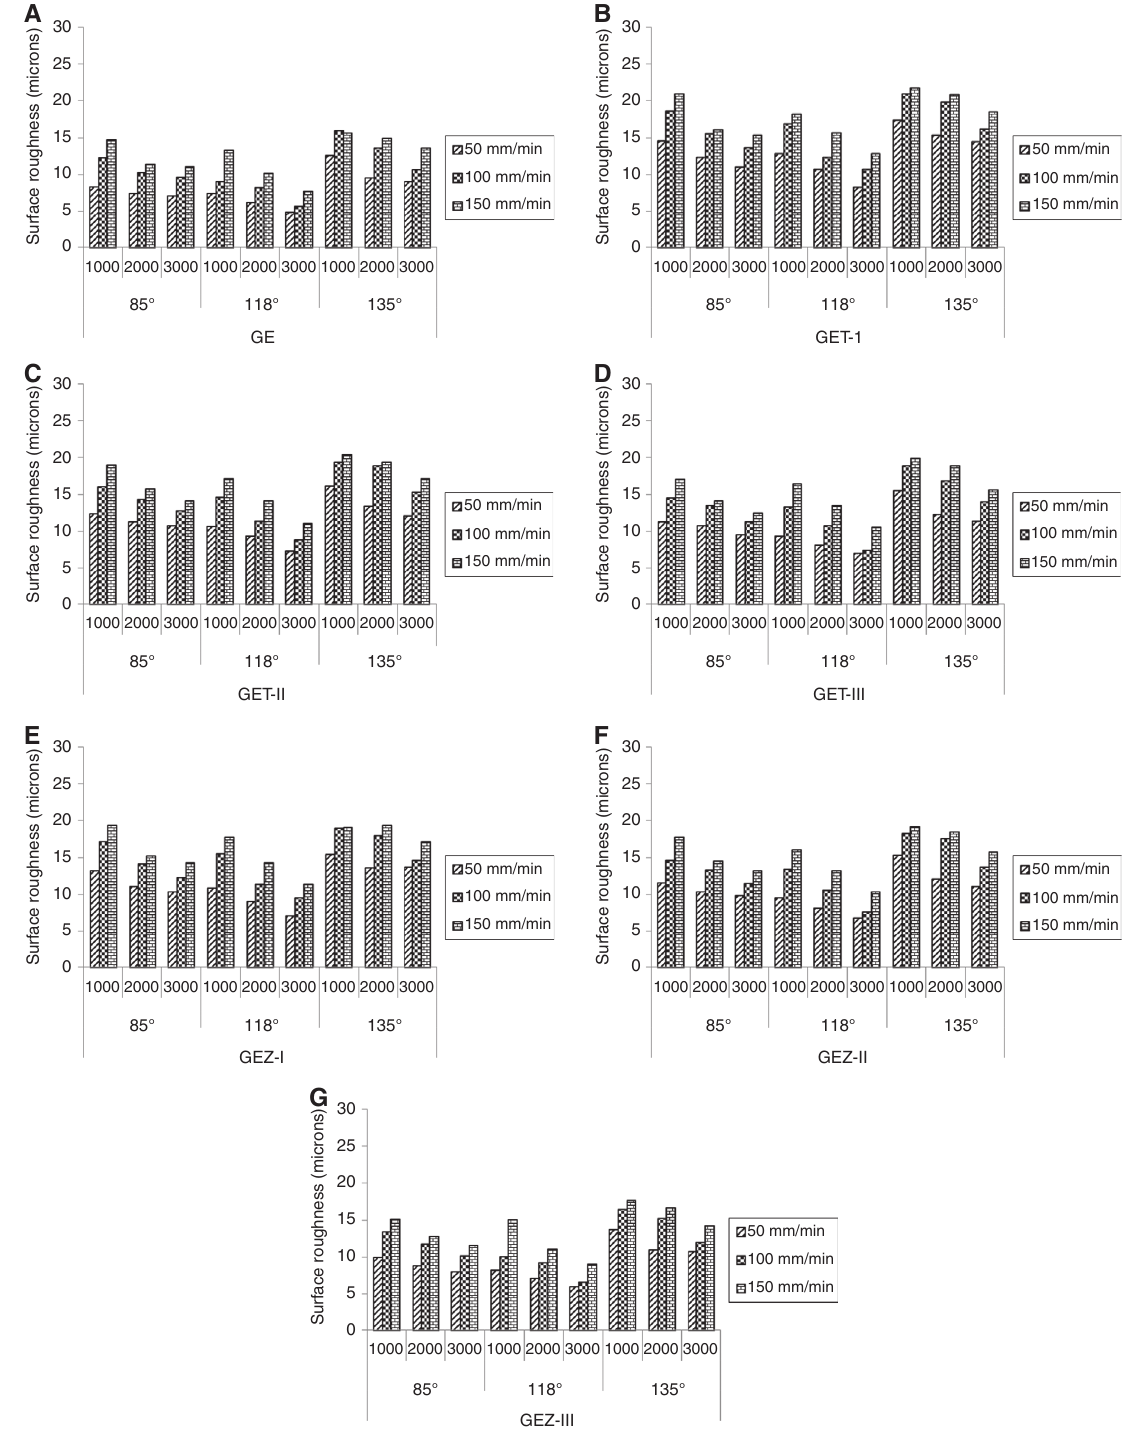
- and ZnS-filled composite. 2